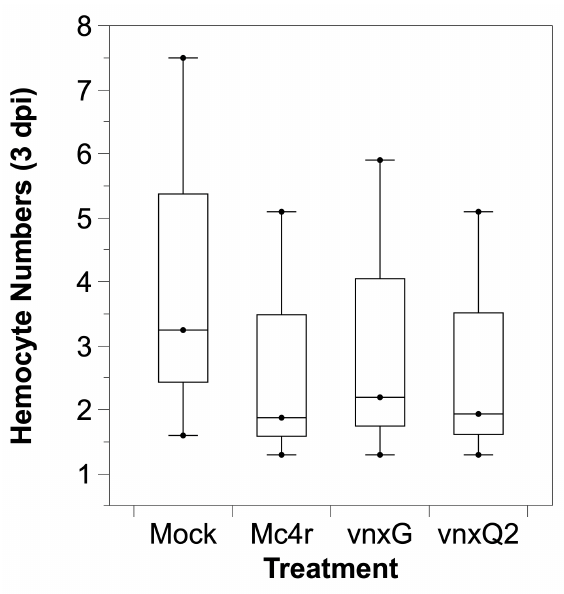
Figure 4. Vinnexin expression does not affect total hemocyte count of H. virescens larvae. Hemocytes were collected and pooled from three larvae at 3 dpi and counted. The unit of cell count is ten million per milliliter.